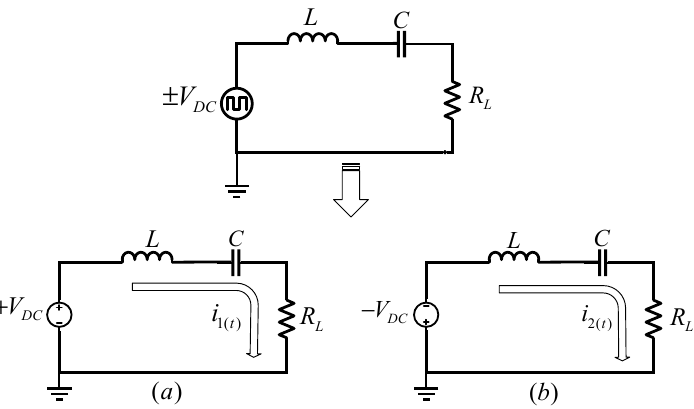
Figure 2. Series RLC resonant circuit with bipolar square voltage source at the input. ( a ) Series RLC circuit when the voltage source is positive. ( b ) Series RLC circuit when the voltage source is nega- tive.